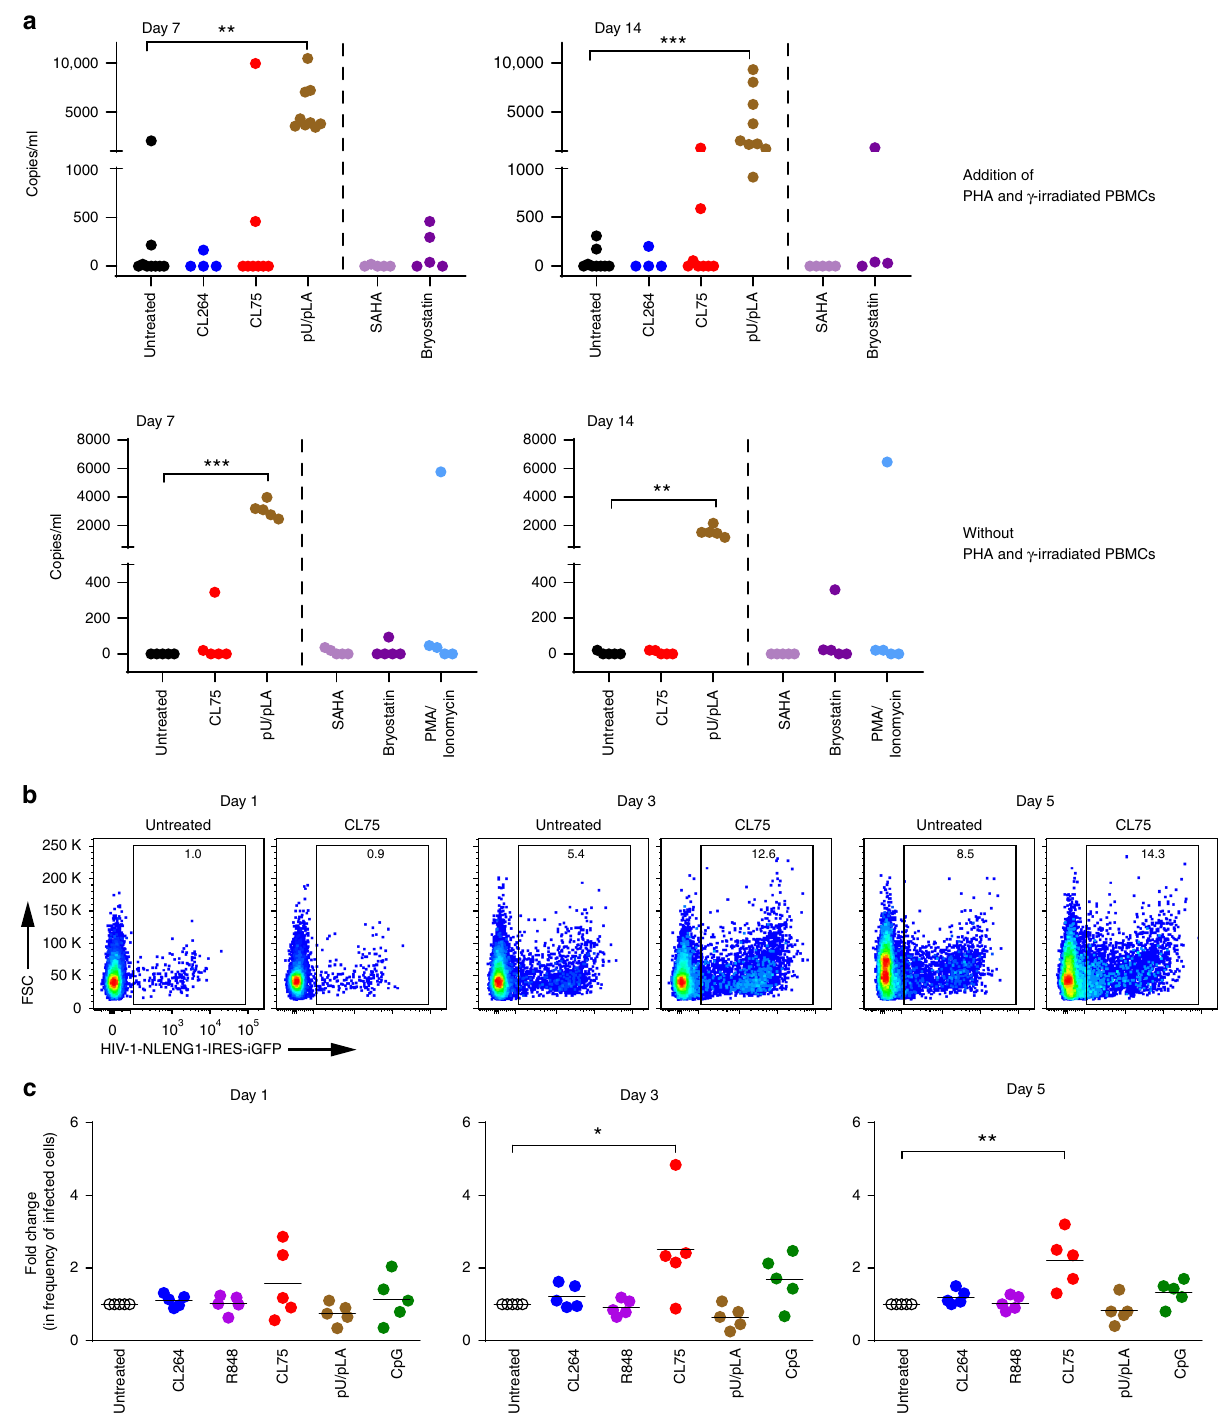
Fig. 7 TLR8 increases HIV replication and reverses latency in CD4 + T cells. a Viral outgrowth assay: CD4 + T cells isolated from aviremic patients were activated with γ -irradiated PBMCs and PHA (nine donors) or left untreated ( fi ve donors) and stimulated with 5 μ g/ml of CL264 (TLR7), CL75, or pU/pLA (TLR8) for the time points indicated. Cells from four treated and all fi ve untreated donors were stimulated with SAHA (335 nM), Bryostatin (10 nM), or PMA/ionomycin (500 nM/1.3 μ M) for 16 h. HIV RNA was quanti fi ed in the supernatant by qPCR. b , c CD4 + T cells isolated from healthy blood donors were TCR-activated in the presence or absence of 5 μ g/ml CL264, R848 (TLR7/8), CL75, pU/pLA, or CpG (TLR9, 5 μ M) for 48 h prior to infection with cell-free NLENG1-IRES (X4 HIV-1). The frequency of eGFP + T cells over time was quanti fi ed using fl ow cytometry; representative dot plot examples of untreated and CL75-treated CD4 + T cells 1 – 5 days post HIV infection are shown in b . Quanti fi cation in c is presented as fold change relative to HIV-1- infected cells in the absence of TLR ligands. The mean value of fi ve independent experiment is indicated. Statistical signi fi cance was determined using repeated measures mixed effects model with Dunnett ʼ s post-test on log-transformed data; signi fi cance levels: * p < 0.05; ** p < 0.01; *** p < 0.001. Source data are provided as a Source Data